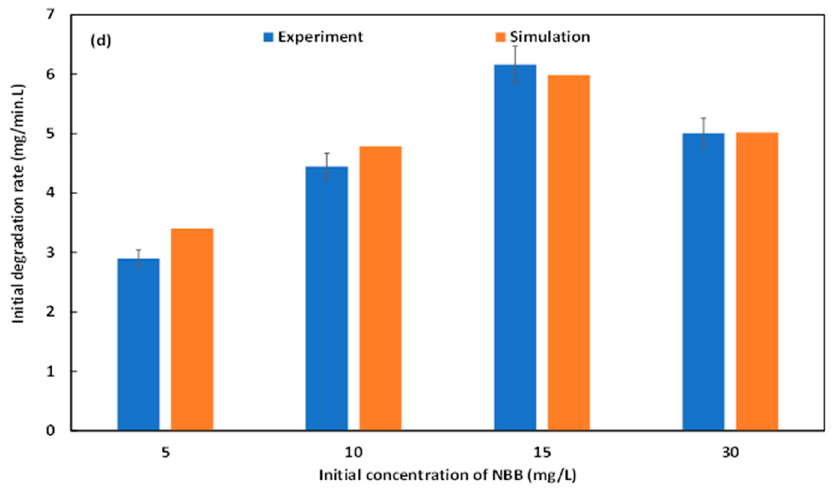
Figure 8. Experimental ( a ) and simulated ( b ) kinetics of GF degradation of NBB vs. time, their corresponding simulated kinetics of hydroxyl radical production ( c ), and comparison of the initial degradation rates obtained both experimentally and numerically ( d ) with different initial concentrations of NBB (pH 3 and 162 µM of added H 2 O 2 ).